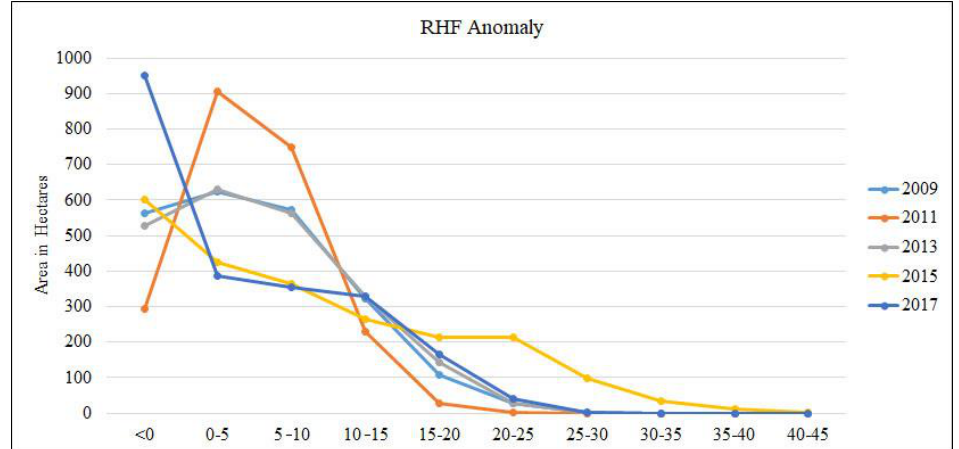
Figure 17. Areas of radiative heat loss anomaly in the Beppu geothermal area from 2009 to 2017, separated into high (above 20 W/m 2 ), middle (5–20 W/m 2 ), and low (less than 5 W/m 2 ) ranges.